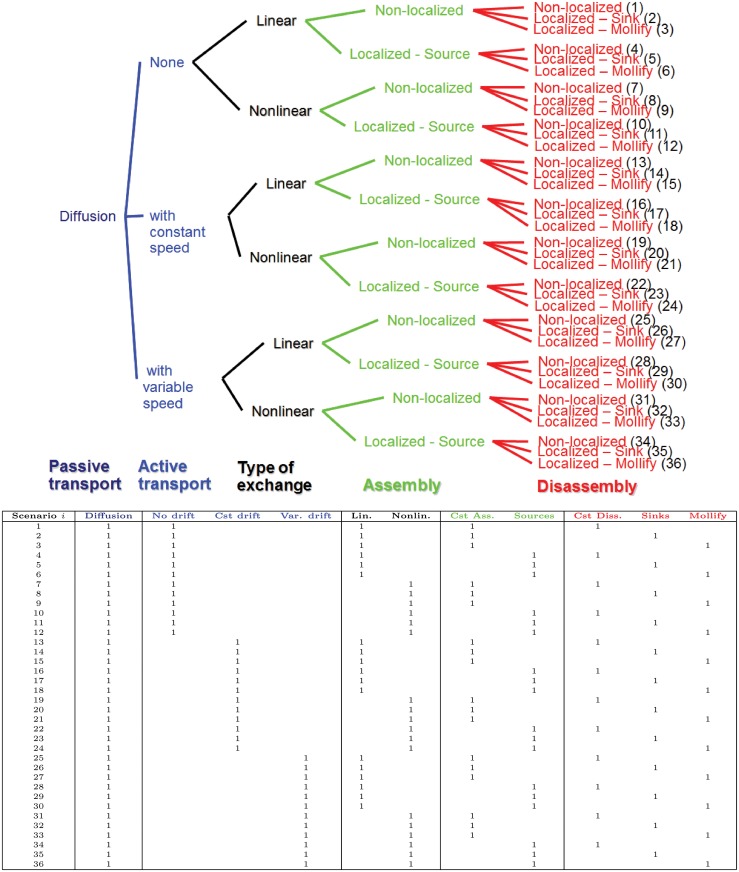
The 36 scenarios to be considered.Top: Number in parentheses is the scenario index i. Bottom: The numerical value 1 denotes that the process of interest is in Scenario i.